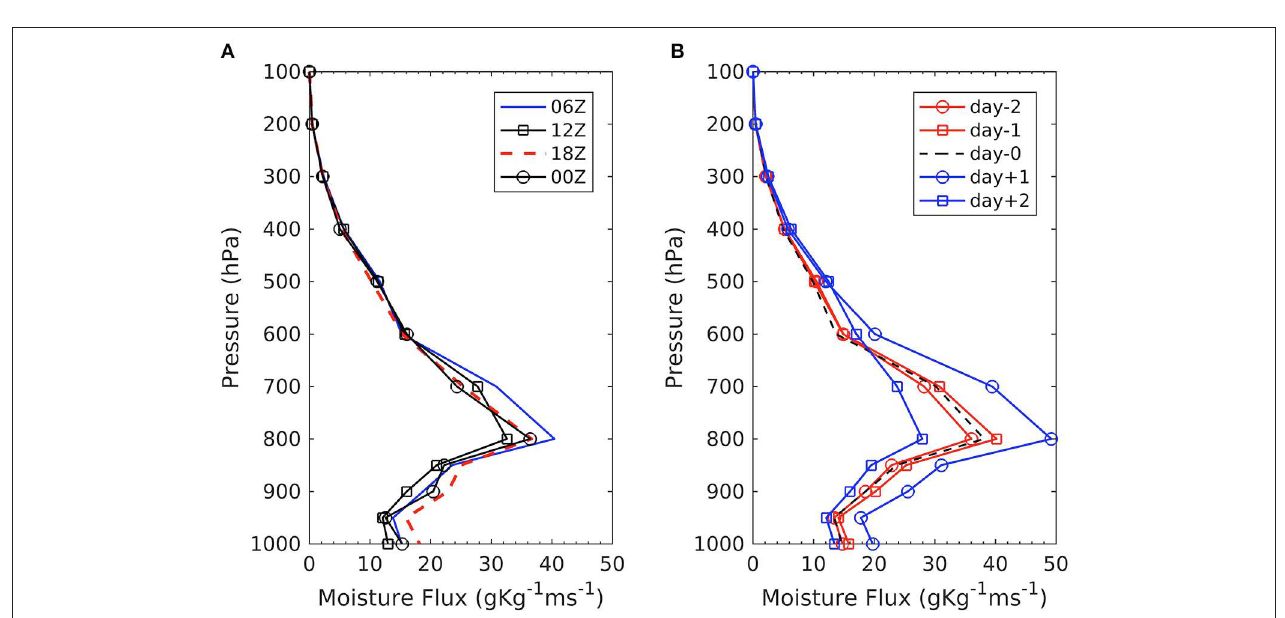
FIGURE 11 | Vertical profile of moisture flux ( q × p u 2 + v 2 ) from ERA-Interim: (A) climatological values at different times of the day (B) during CAI in September-October-November (SON) at (71.25 ◦ W , 12.75 ◦ S ).